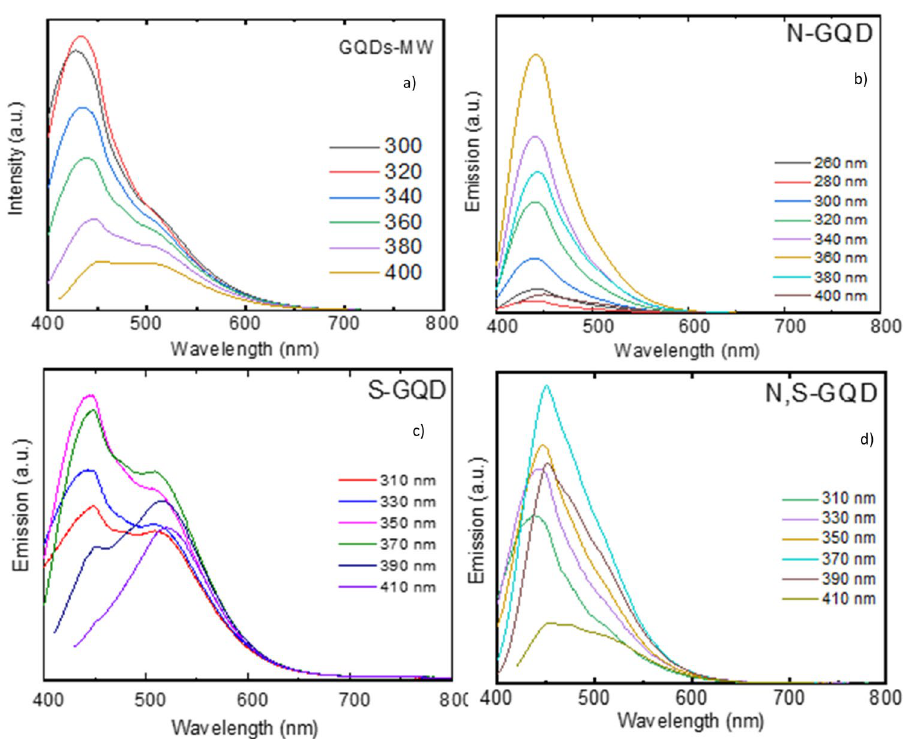
Figure 5. Emission spectra of ( a ) GQDs-MW, ( b ) N-GQDs, ( c ) S-GQDs and ( d ) N,S GQDs, showing that the approximate size of the GQDs fall in the range of 2–5